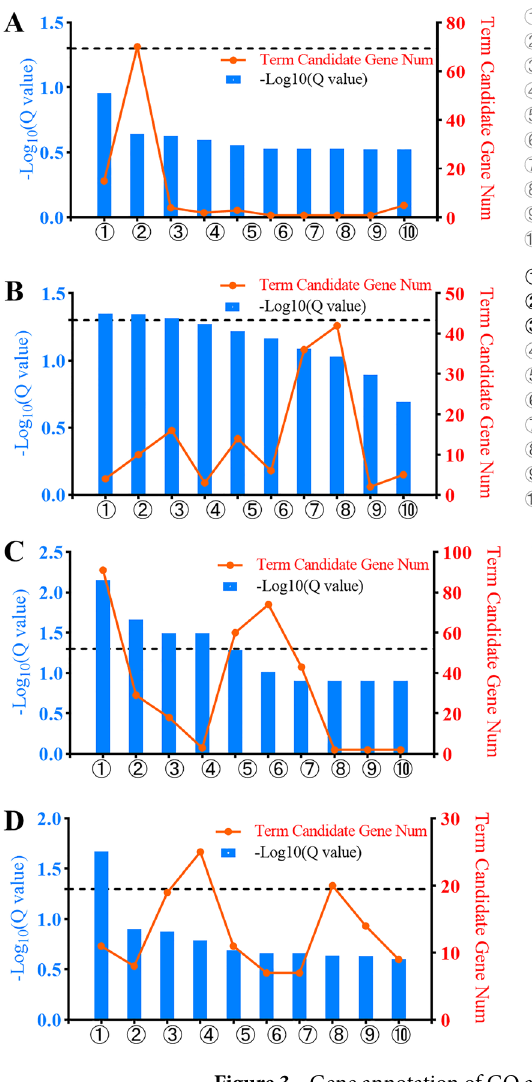
Figure 3. Gene annotation of GO and KEGG pathways enriched in DEGs. ( A – C ) The biological processes ( A ), molecular functions ( B ) and cellular components ( C ) of the DEGs; ( D ) Annotation of 689 DEGs from the KEGG pathway database. The text in bold represents the pathway that Q <